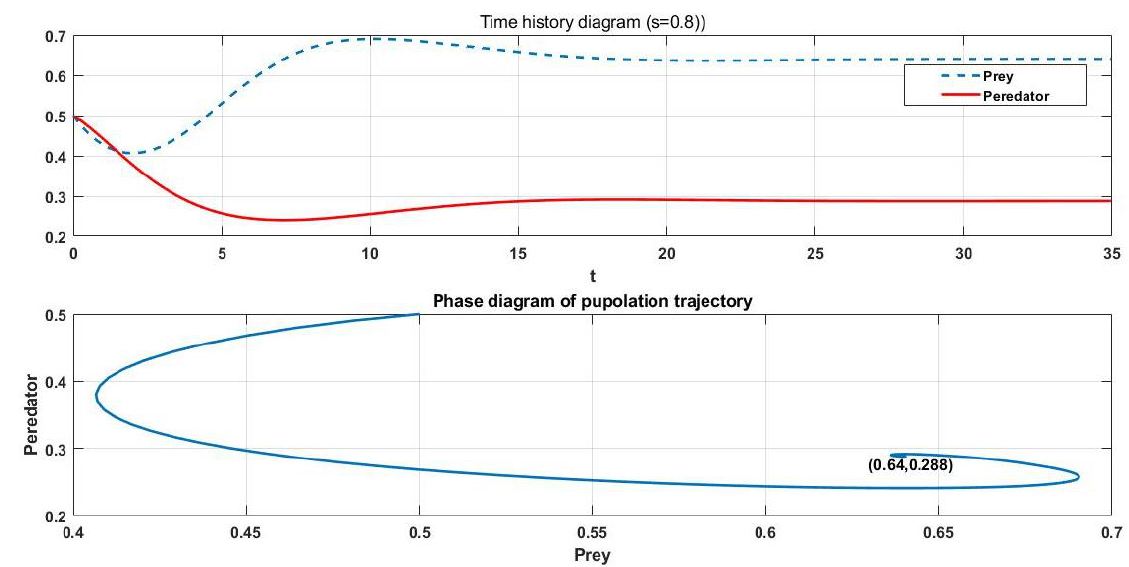
Figure 9. Stable deterministic system time history diagram and phase diagram with initial value (0.5, 0.5).